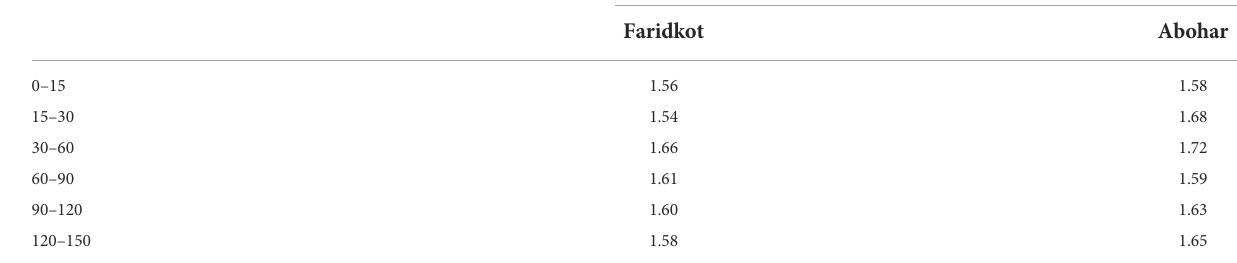
TABLE 3 Layer wise bulk density of experimental